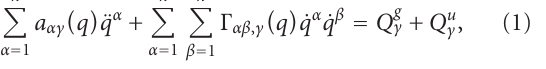
Figure 1: Robot-assisted brachytherapy system (Euclidian). Three basic subsystems are shown: 7DOF robot subsystem (surgery module), supporting platform and cart.